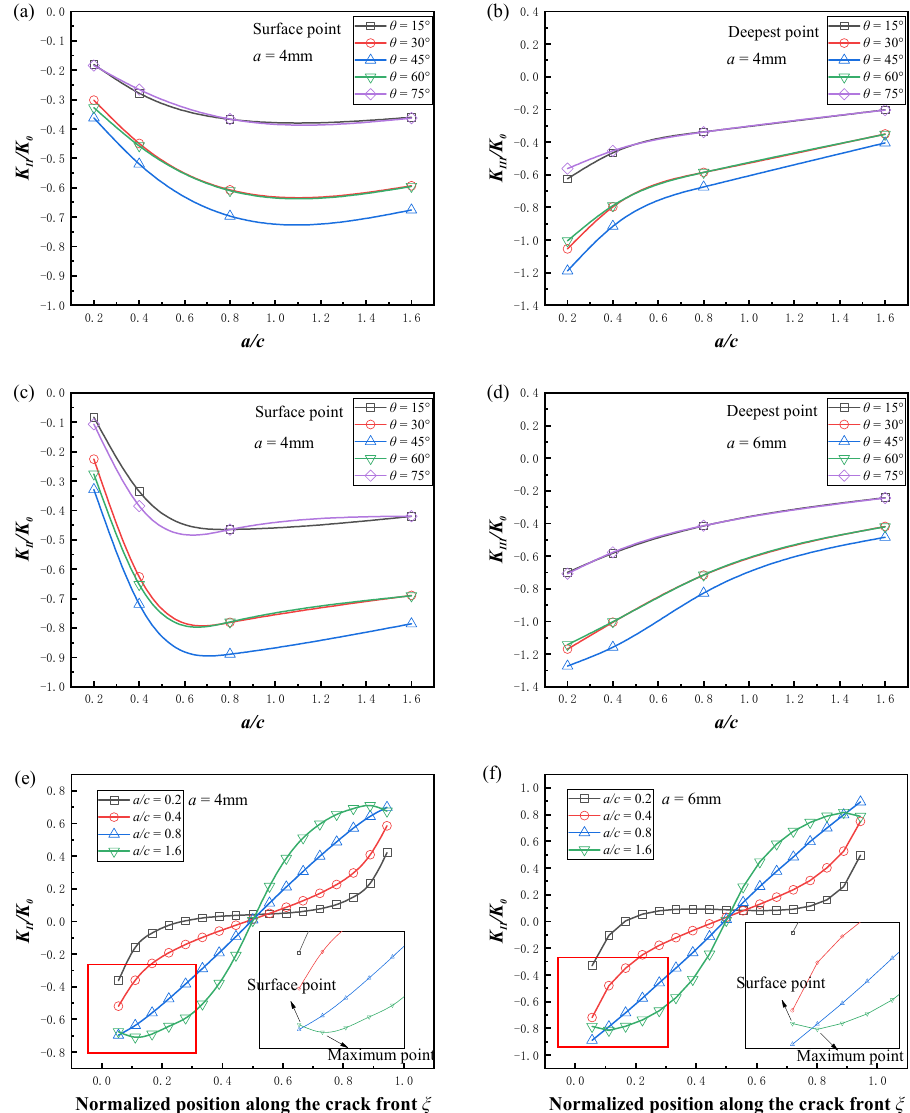
Figure 9. Effect of the aspect ratio on the normalized SIFs ( µ = 0). ( a ) Normalized K II ( a = 4 mm, a / t = 0.4); ( b ) normalized K III ( a = 4 mm, a/t = 0.4); ( c ) normalized K II ( a = 6 mm, a / t = 0.6); ( d ) normalized K III ( a = 6 mm, a/t = 0.6); ( e ) normalized K II near the crack surface ( a = 4 mm, a / t = 0.4); ( f ) normalized K II near the crack surface ( a = 6 mm, a / t = 0.6).